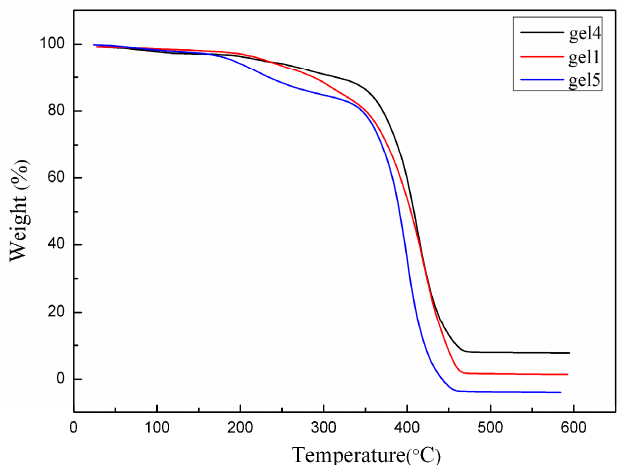
Figure 4. Thermogravimetric analysis curves of physically-crosslinked hydrogels and chemically-crosslinked hydrogels and double-crosslinked hydrogels.